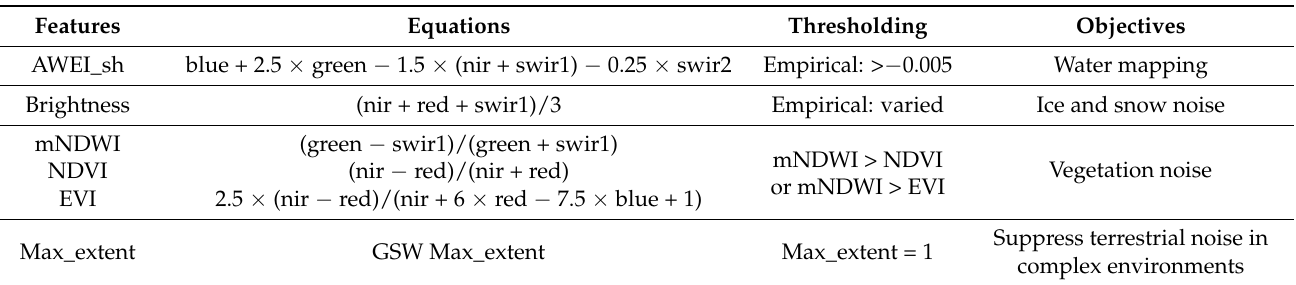
Table 2. Spectral indexes and image characteristics that were used for water delineation from backgrounds using Landsat images.